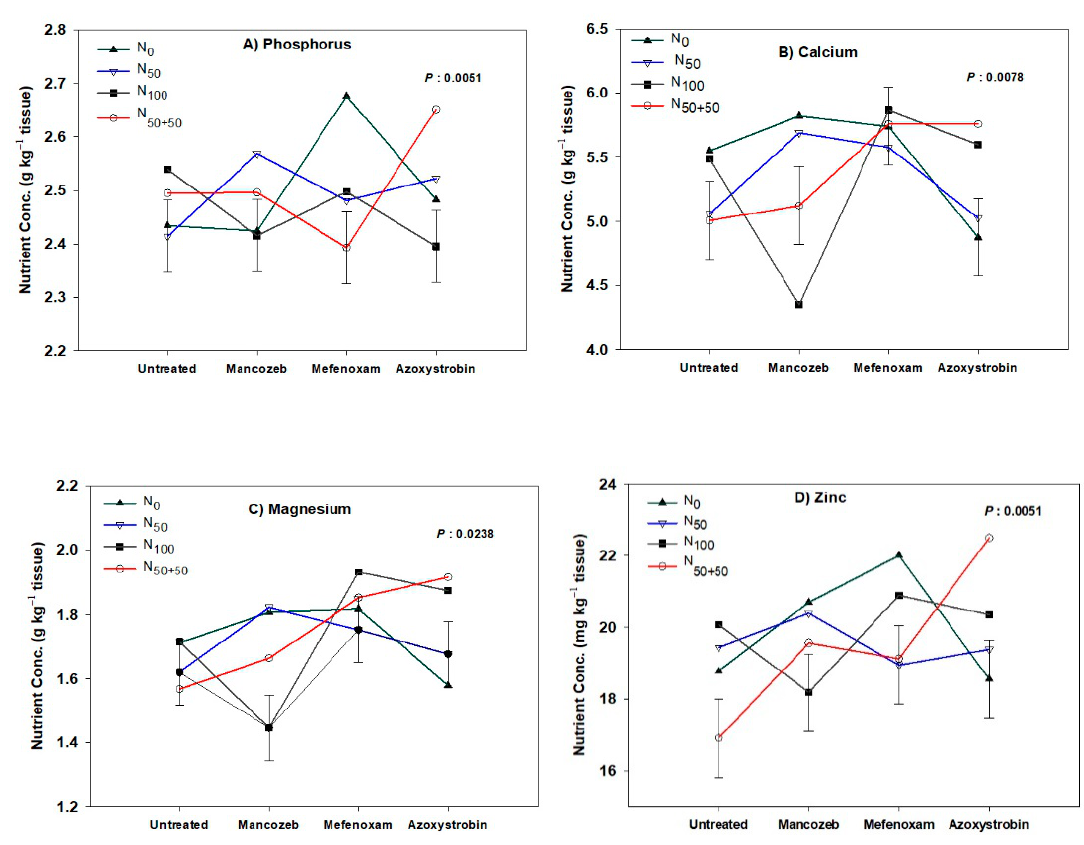
Figure 3. Interaction effects of Nitrogen × Fungicide on sugarcane leaf tissue concentrations of ( A ) Phosphorus, ( B ) Calcium, ( C ) Magnesium, and ( D ) Zinc nutrients in plant crop 2016. Error bars represent standard error of the mean. Table 3. Least Square means for seasonal sugarcane leaf tissue nutrient concentrations of macro and micro-nutrients and nutrient balance index (NBI) in 2016 plant